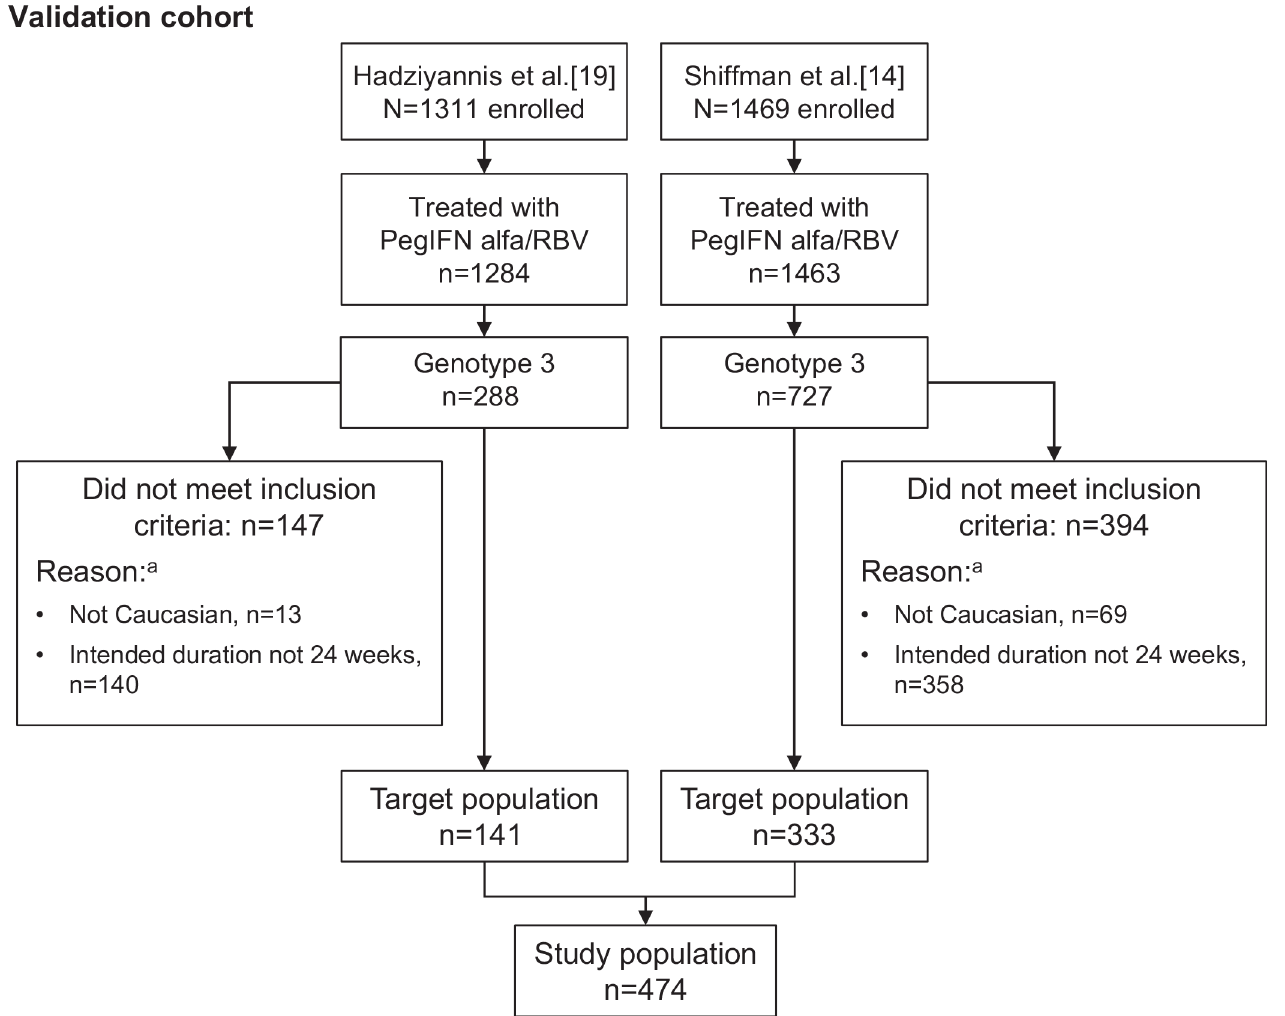
Fig 2. Patient selection for the validation